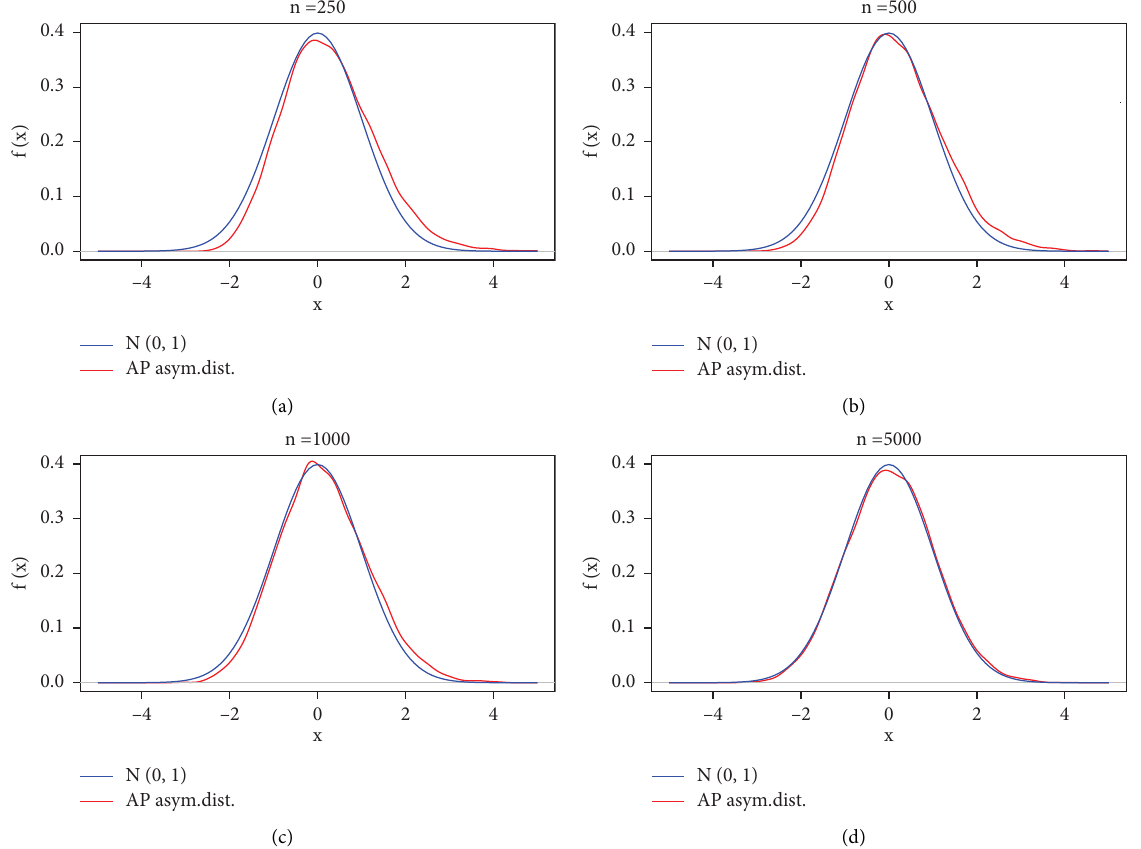
Figure 1: Te approximation behavior of the asymptotic distribution of AP